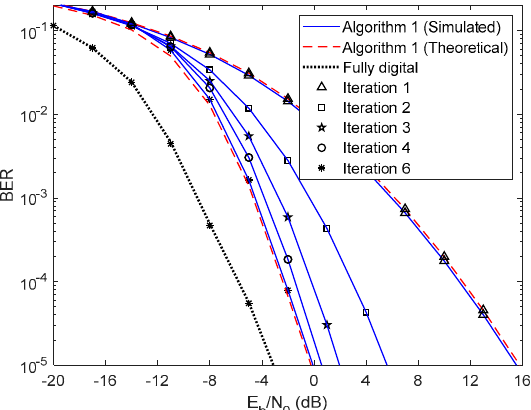
Figure 6. Performance comparison between the Algorithm 1, the two-step, and GS/MMSE approaches for the PCSI precoder with ULA configuration and QPSK modulation.